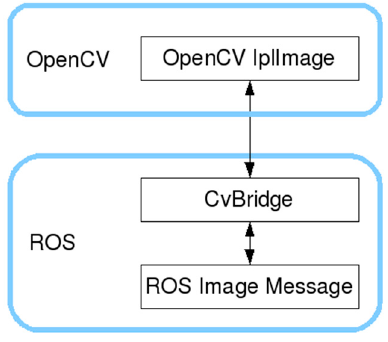
Figure 1. Cv_bridge package operation scheme for image information transfer.